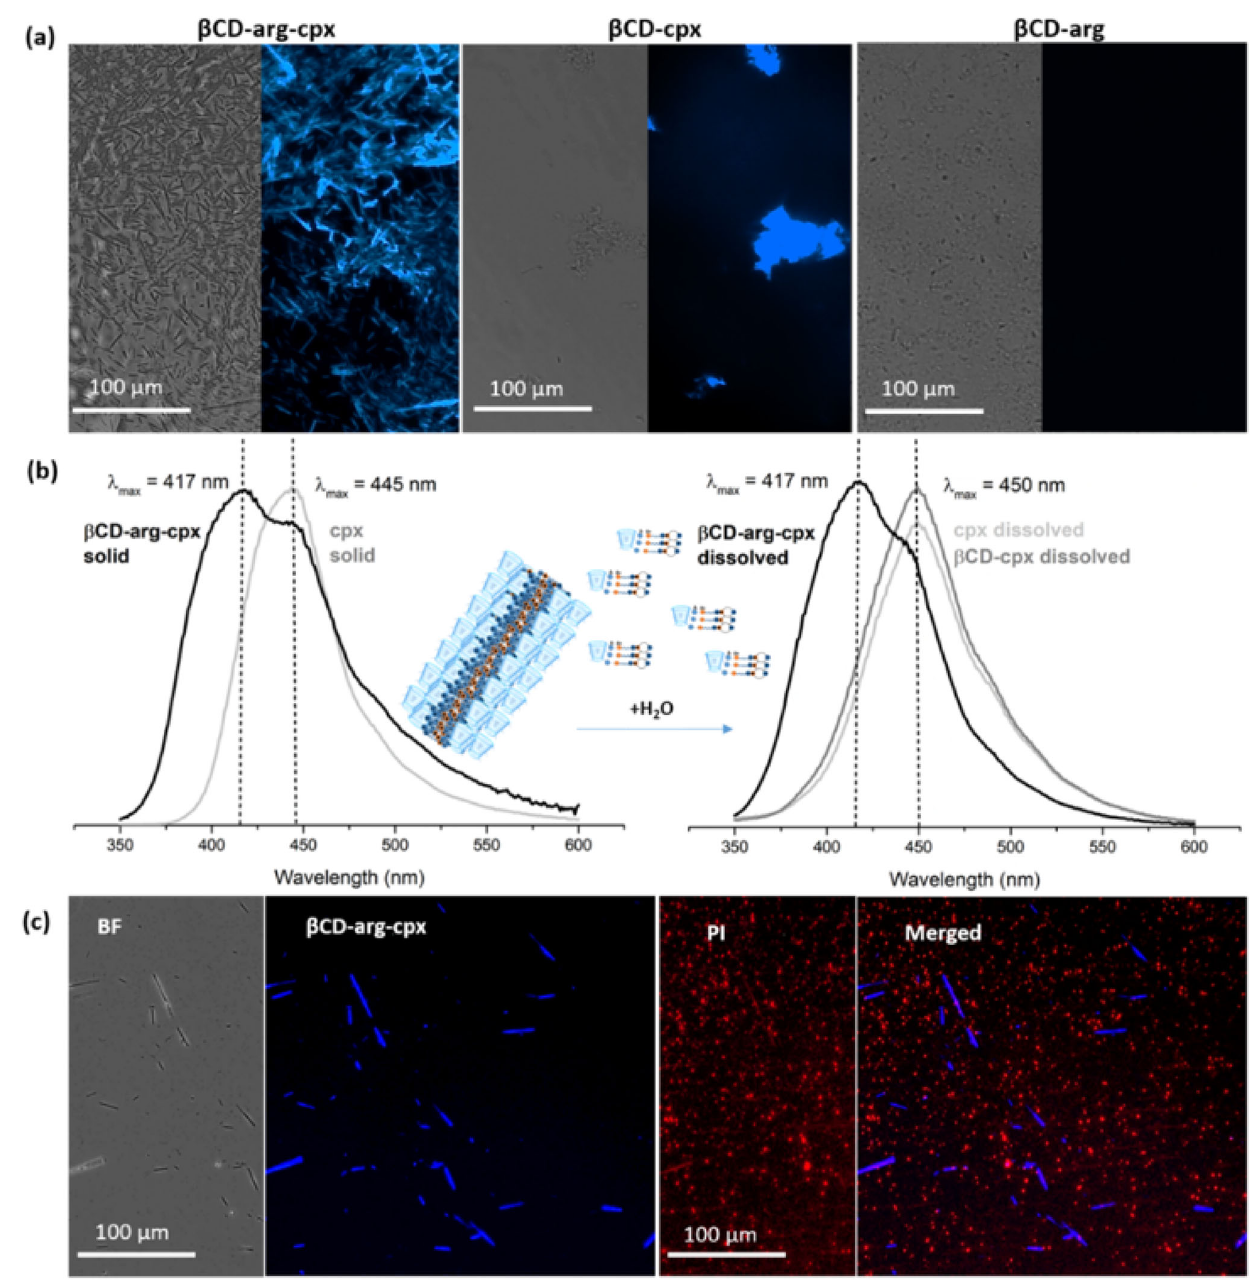
Fig. 4 Fluorescence and detection properties of the β CD-arg-Cpx complex. Blue fl uorescence of cpx-containing ( β CD-arg-cpx and β CD-cpx) complexes (not detected for β CD-arg) ( a ). Fluorescence spectra of β CD-arg-cpx and free cpx (and comparable β CD-cpx complex) before and after dissolving in water con fi rming different dissolving mechanisms (dissolved complex vs. dissolved free drug) ( b ). Detection of β CD-arg-cpx and of bacteria (100 μ g/ml of the complex after 10 min exposure to P. aeruginosa PAO1 stained with propidium iodide (PI, red fl uorescence, detecting dead bacteria) ( c